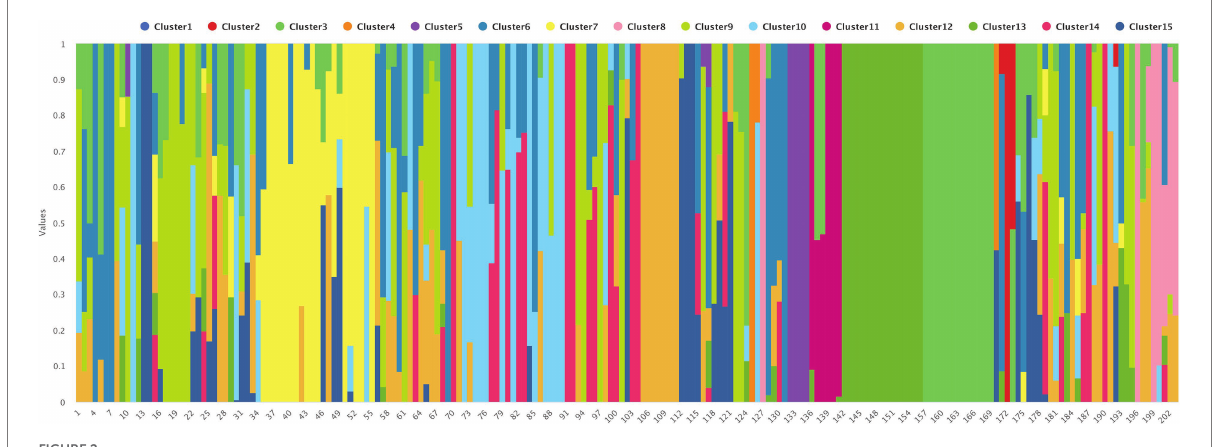
FIGURE 2 The population structure of 203 chickpea interspecific lines and accessions based on k = 15.